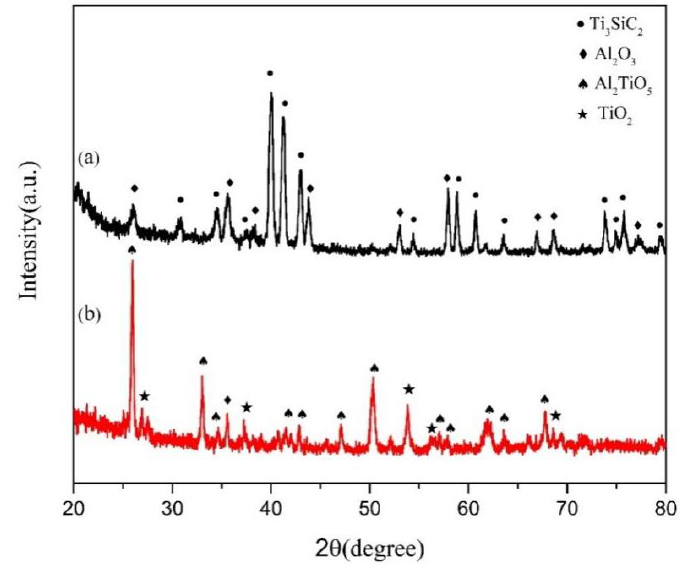
Figure 3. X-ray diffraction patterns of the TSC60 (a) before oxidation and (b) after oxidation at 1400 °C for 4 h.